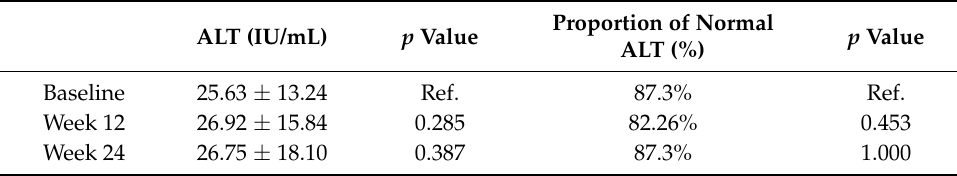
Table 2. Biochemical response of TDO treatment at Weeks 12 and